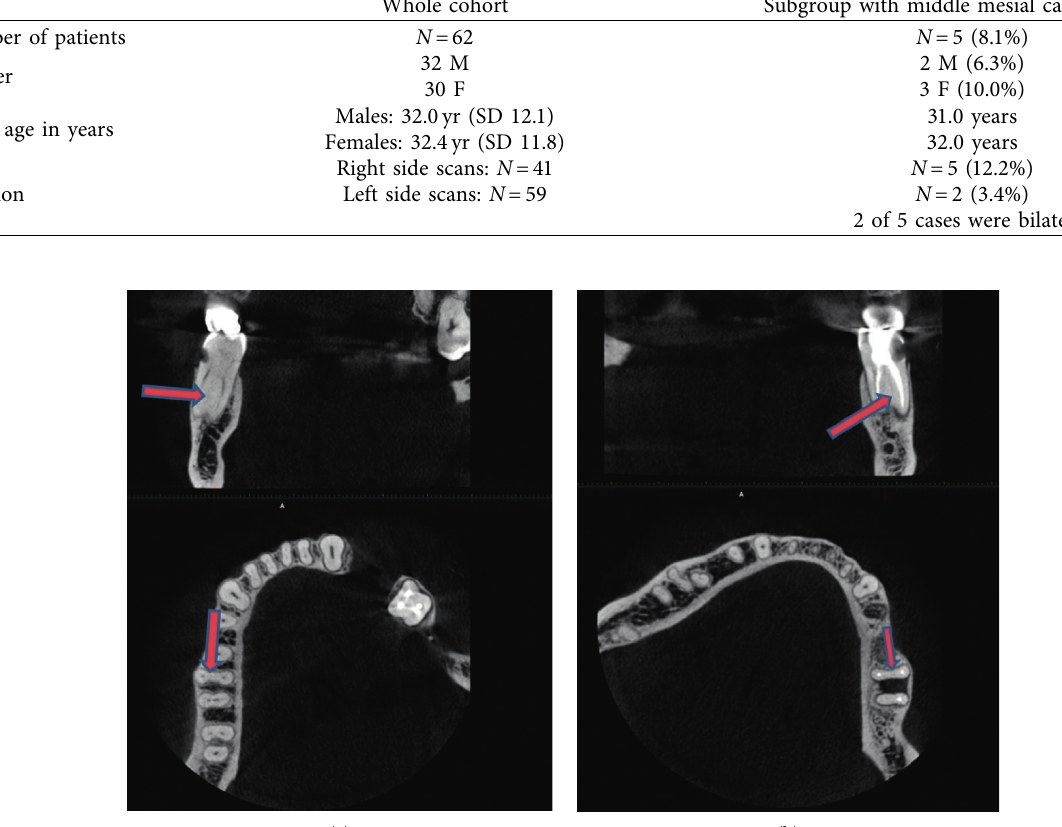
Figure 1: Case 1: a 26-year-old female with bilateral middle mesial canals in the mandibular first molars. The distal roots of the same teeth have two canals.